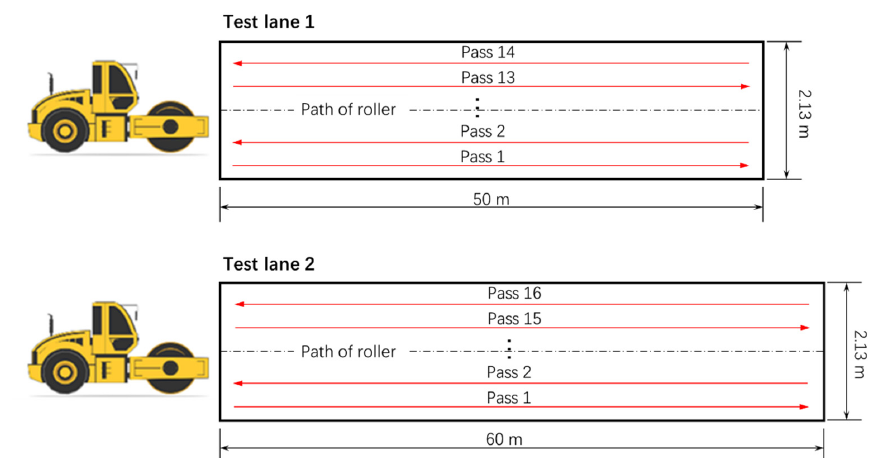
Figure 3. Test lanes.